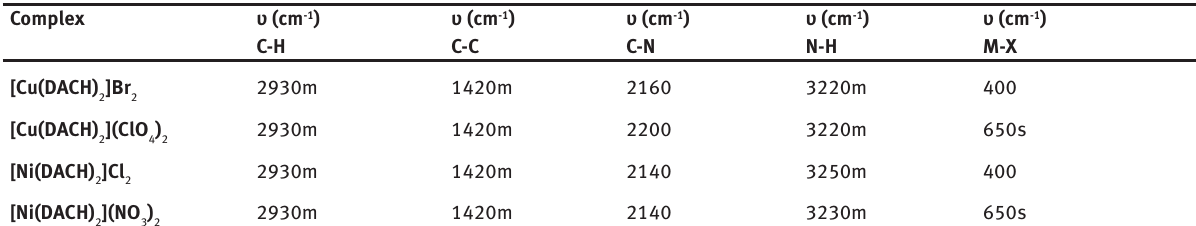
Table 4: Assignment of IR bands for complexes of DACH. Complex